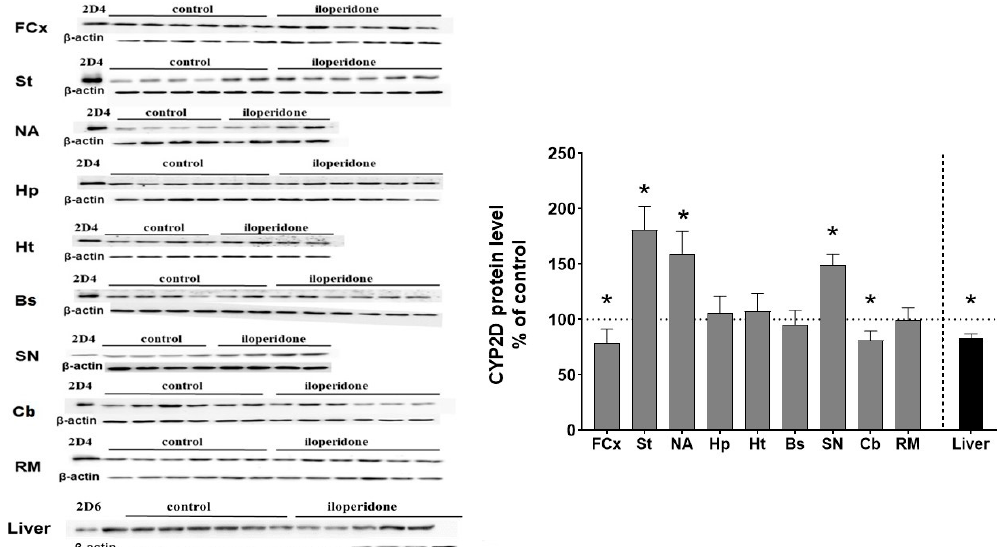
Figure 3. The effect of two-week treatment with iloperidone on the CYP2D protein levels measured in microsomes derived from the selected brain structures or liver. The presented values are the means ± S.E.M. of 12 samples (from 12 animals) for the cerebellum, remainder of brain and the liver, of 6 samples (each sample contained 2 pooled brain structures from 2 animals) for the frontal cortex, brain stem, striatum and hippocampus or of 4 samples (each sample contained 3 pooled brain structured from 3 animals) for the hypothalamus, nucleus accumbens and substantia nigra. The representative CYP2D protein bands of the Western blot analysis are shown. Brain or liver microsomal protein (10 µ g) was subjected to Western blot analysis. cDNA expressed CYP2D4 protein (Bactosomes) and cDNA expressed CYP2D6 protein (Supersomes) was used as a positive control. Student’s t -test: * p < 0.05 vs. control group. FCx—the frontal cortex, St—the striatum, NA—the nucleus accumbens, Hp—the hippocampus, Ht—the hypothalamus, Bs—the brain stem, SN—the substantia nigra, Cb—the cerebellum and RM—the remainder.